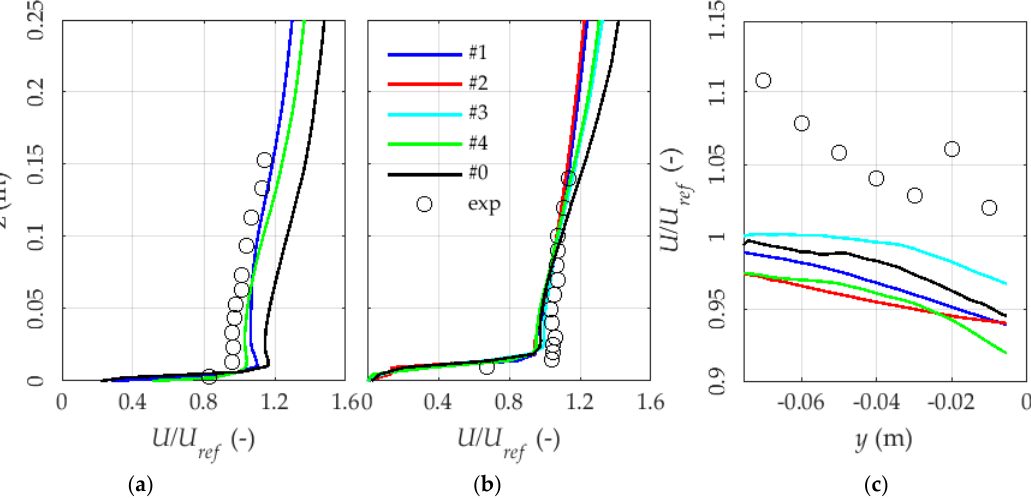
Figure 7. Mean horizontal wind speed at the rooftop of the Muirhead tower ( a ) and Biosciences building ( b , c ).